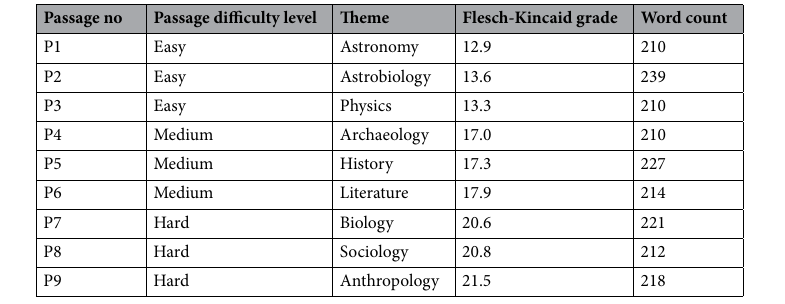
Table 1. Information of the passages.